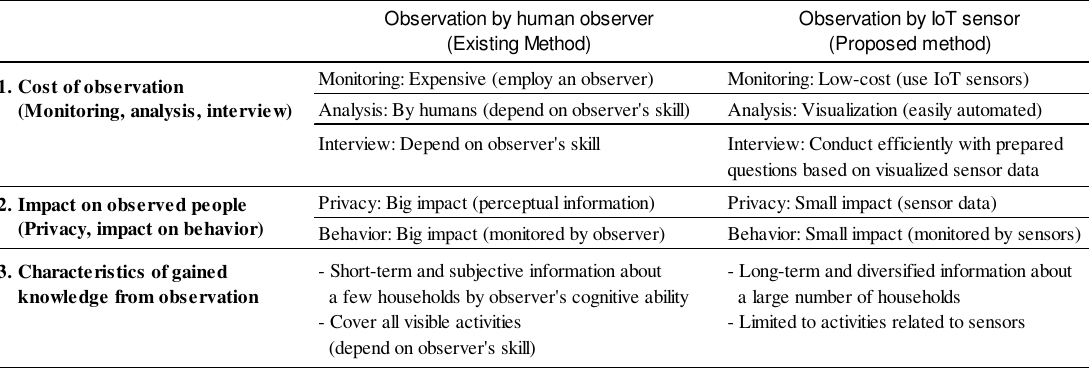
Table 1. Comparison between human-based and Internet of Things (IoT) sensor-based